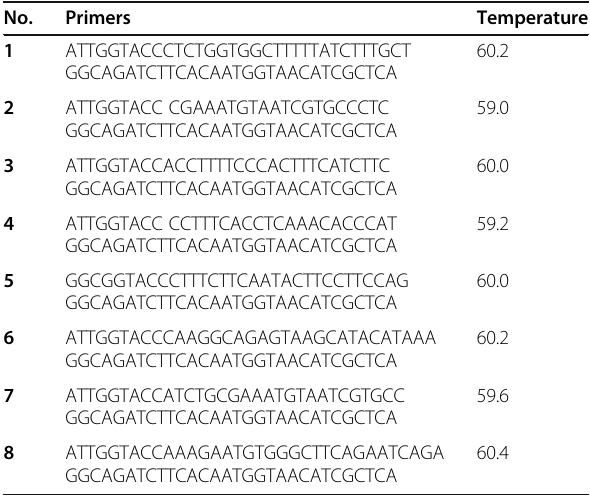
Table 6 List of primers used in the experiment No. Primers